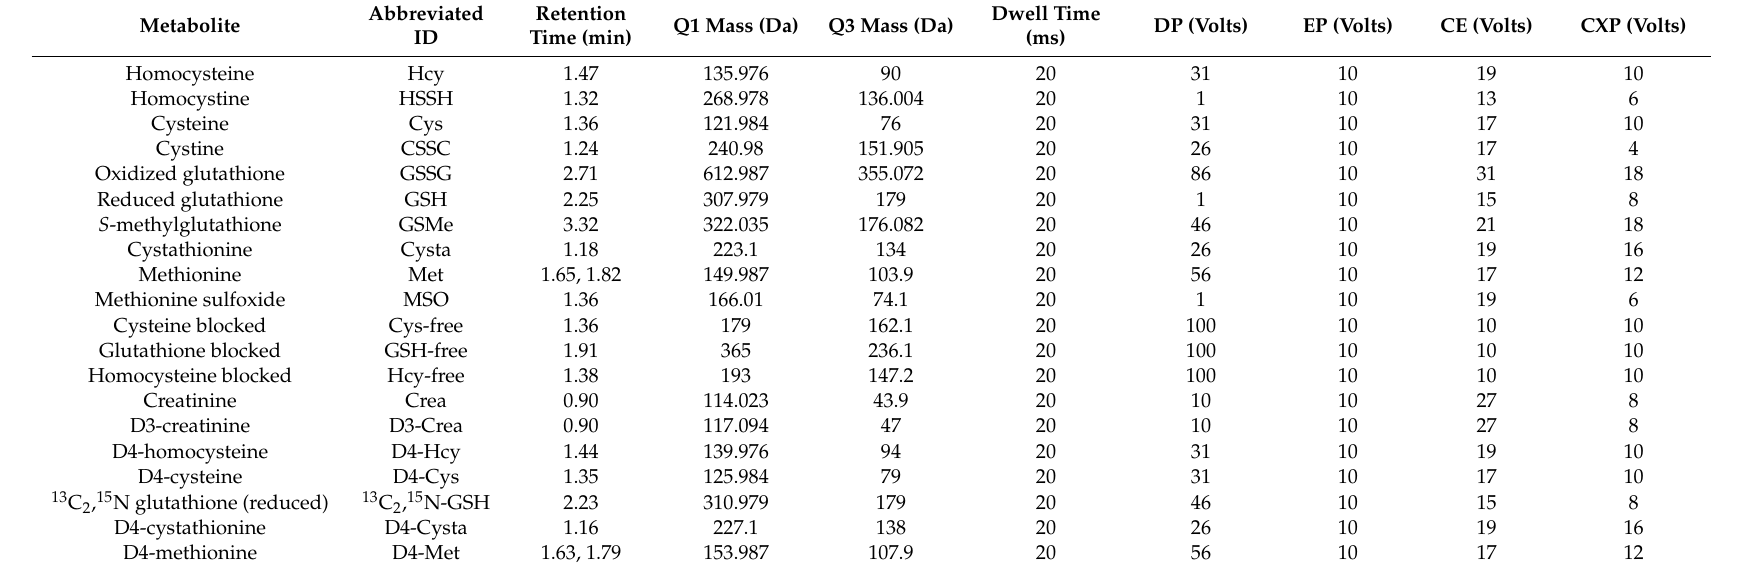
Table 1. Mass transitions and optimized mass spectrometry parameters for the detection of thiol and thioether metabolites and